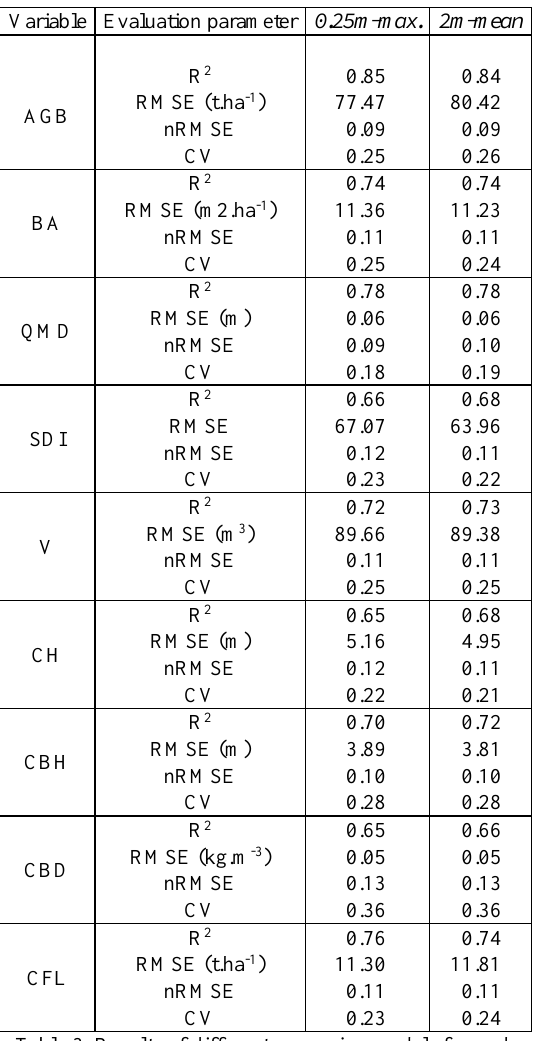
Table 3. Results of different regression models for each estimated variable